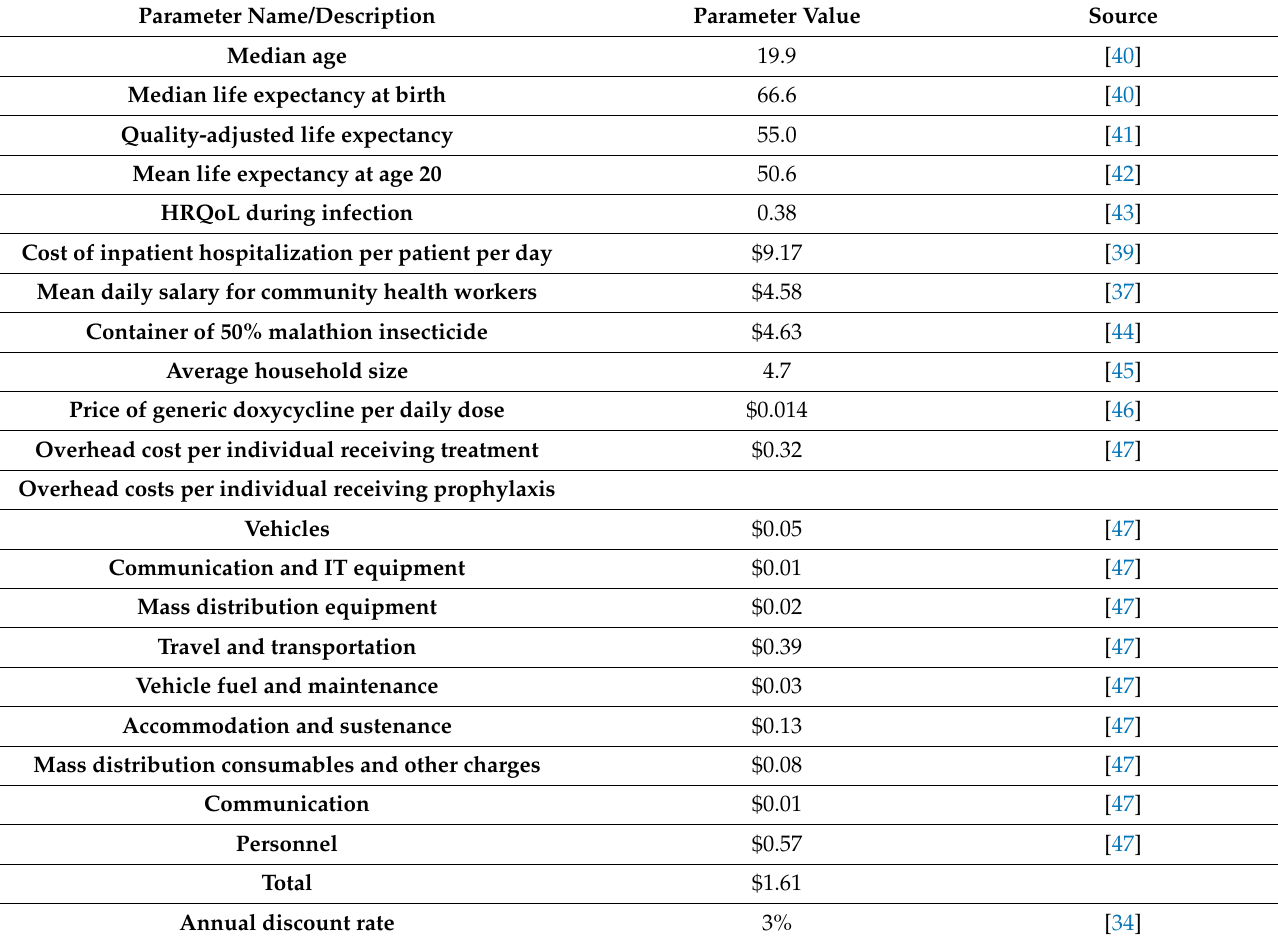
Table 2. Cost and Utility Parameter Values and